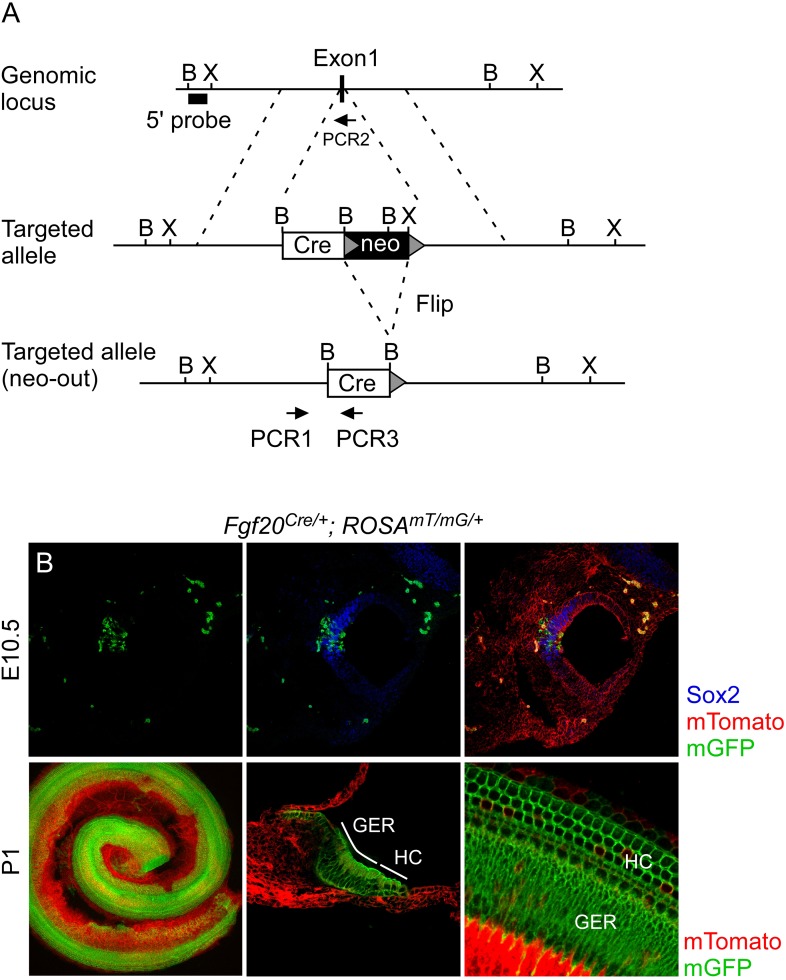
Generation of an Fgf20Cre knockin mouse line.(A) Schematic diagram showing targeting of the Fgf20 genomic locus. Homologous recombination in mouse ES cells was used to insert a GFP:Cre (Cre) gene and neo selection cassette (flanked by Flip recombination target sequences, grey triangles) into exon 1 of Fgf20. F1 mice were bred to mice that express Flip recombinase in the germline to excise the neo selection cassette. Arrows indicate PCR primers used for genotyping. B, BamH1; X, Xho1. (B) Fgf20Cre/+; ROSA26mT/mG/+ (ROSAmT/mG/+) double transgenic mice showing the cumulative lineage of Fgf20Cre expressing cells (green) in the Sox2+ prosensory domain (blue) at E10.5 and in HCs, SCs, and the greater epithelial ridge (GER) at P1. Recombination at the ROSA26mT/mG locus silences membrane localized Tomato (mT) and activates membrane localized GFP (mG).